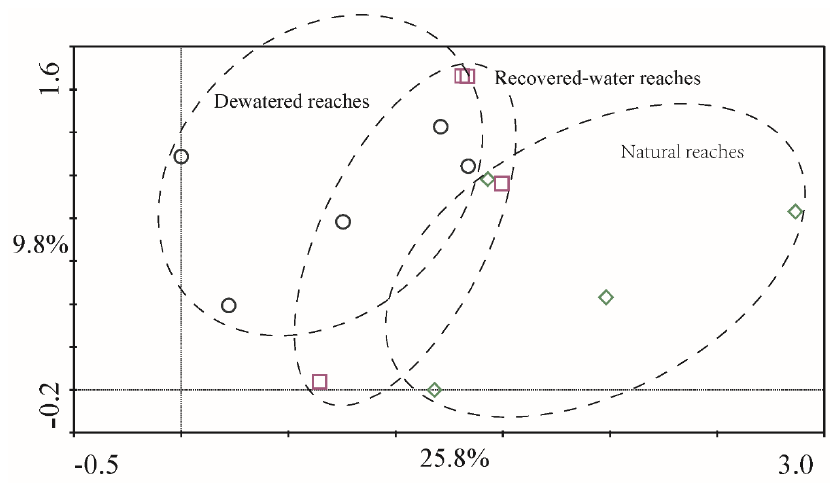
Figure 8. Ordination diagrams of macroinvertebrates under the runoff regulation grouping from QYR in 2012.